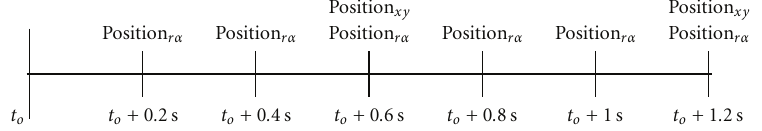
Figure 4: Sensor reports from di ff erent sensors are interleaved to provide uniform reporting.